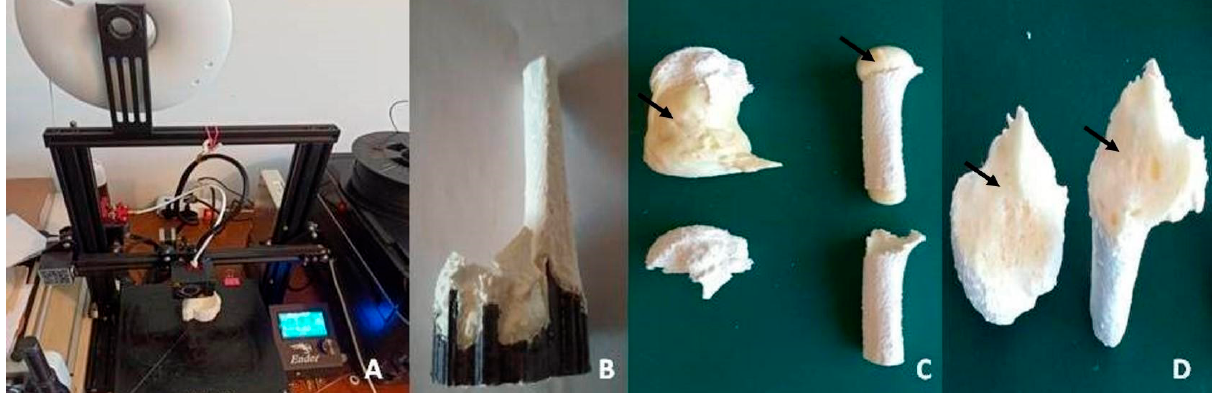
Figure 1. The 3D printer ( A ) creates the real-size model with support structures to be removed (in this case, coloured in black to highlight them); ( B ) the polyurethane foam is then applied (black arrows); and ( C ) once dried, the excess parts are removed, simulating cancellous bone and marrow (black arrows) ( D ).